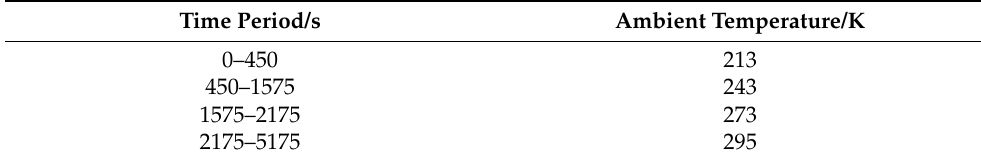
Table 2. Ambient